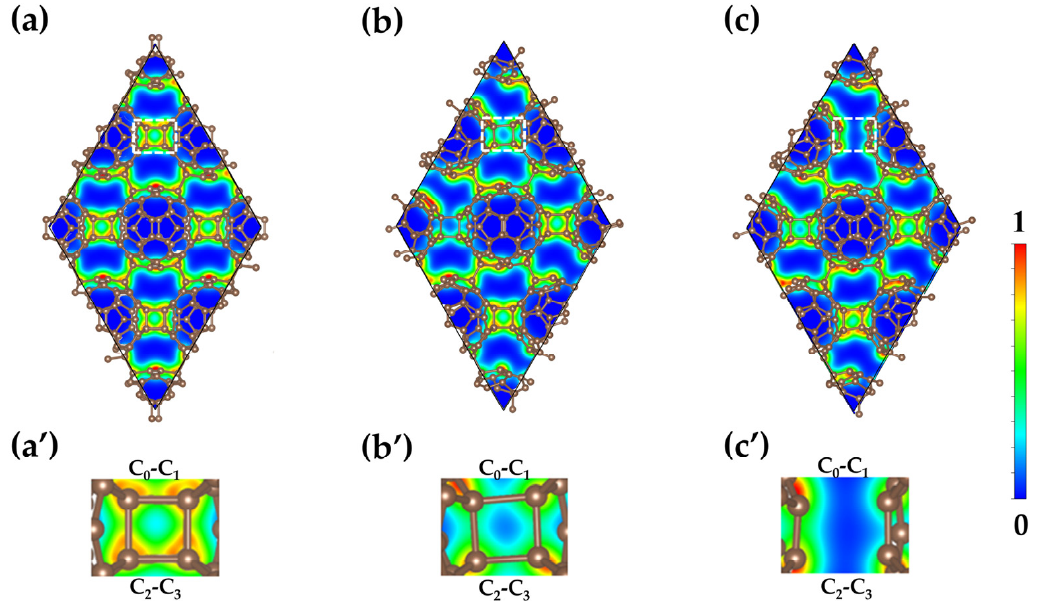
Figure 5. Electronic localization function (ELF) of qhp-C 60 at ( a ) 0 K, ( b ) 300 K, and ( c ) 600 K. Here, ( a ′ ), ( b ′ ), and ( c ′ ) are, respectively, enlarged subgraphs.